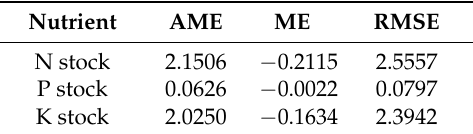
Table 3. Cross-validation indices for ordinary kriging (OK).